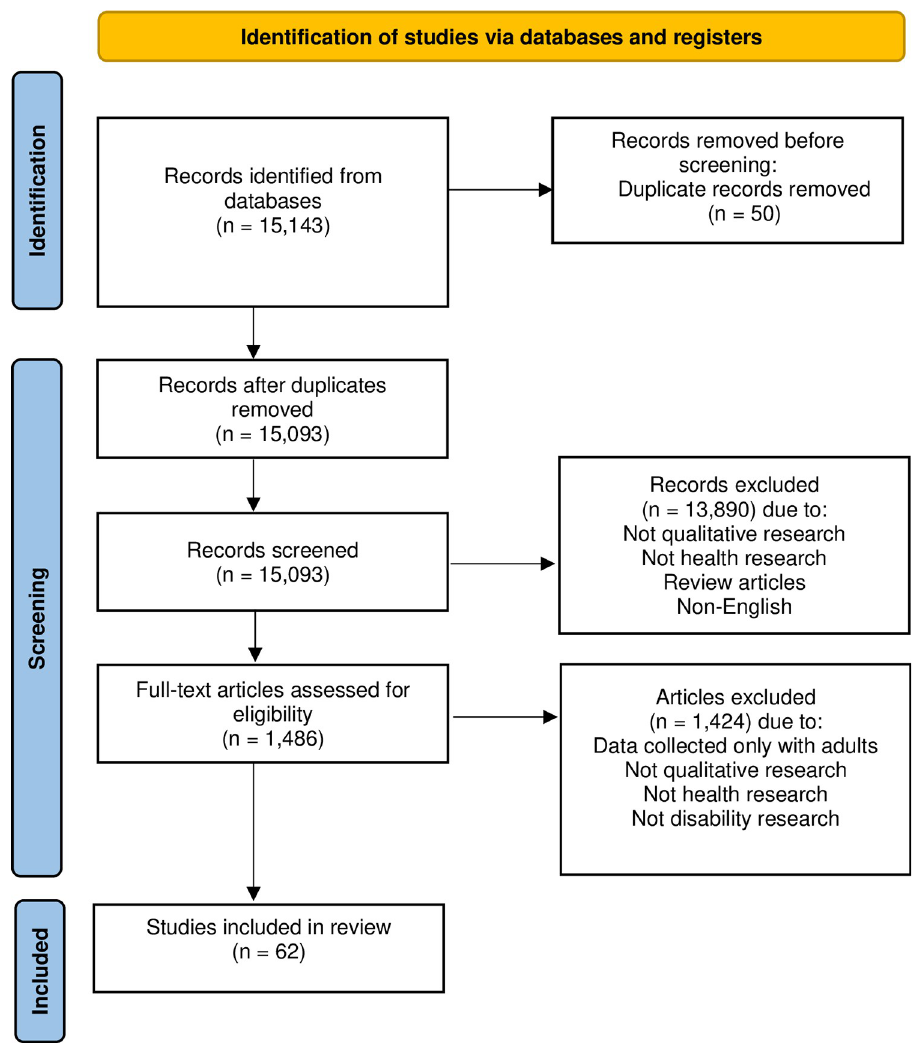
Fig 1. PRISMA flow